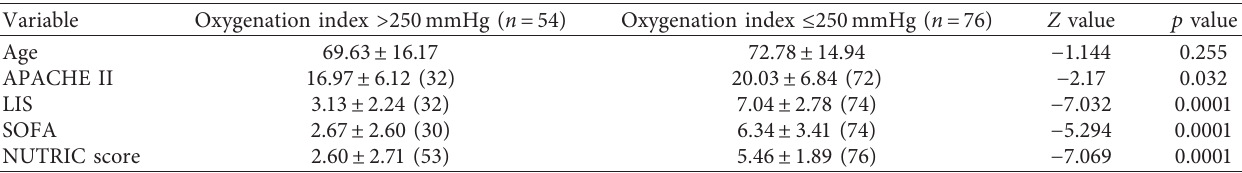
Table 2: Age, APACHE II, LIPS, SOFA, and NUTRIC scores.